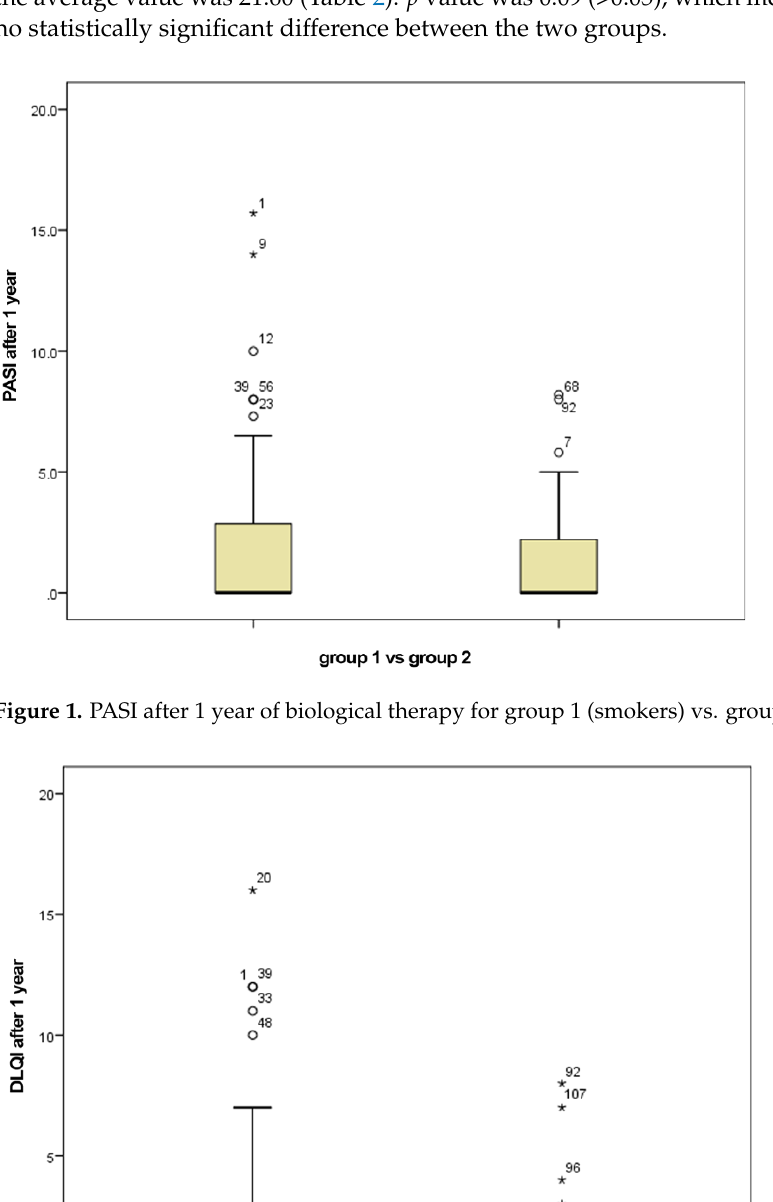
Table 1. DIFFPASI in group statistics.